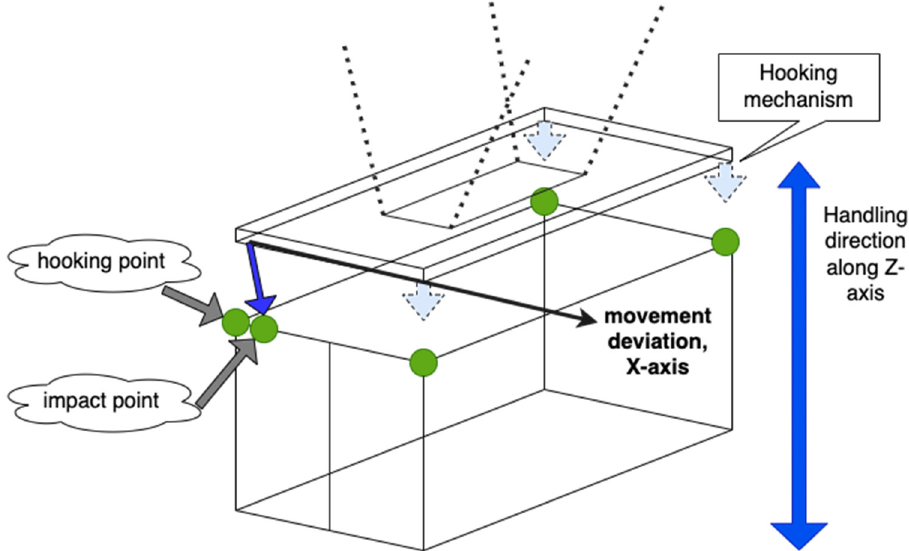
Figure 3. Schematics of the impacts’ causes.